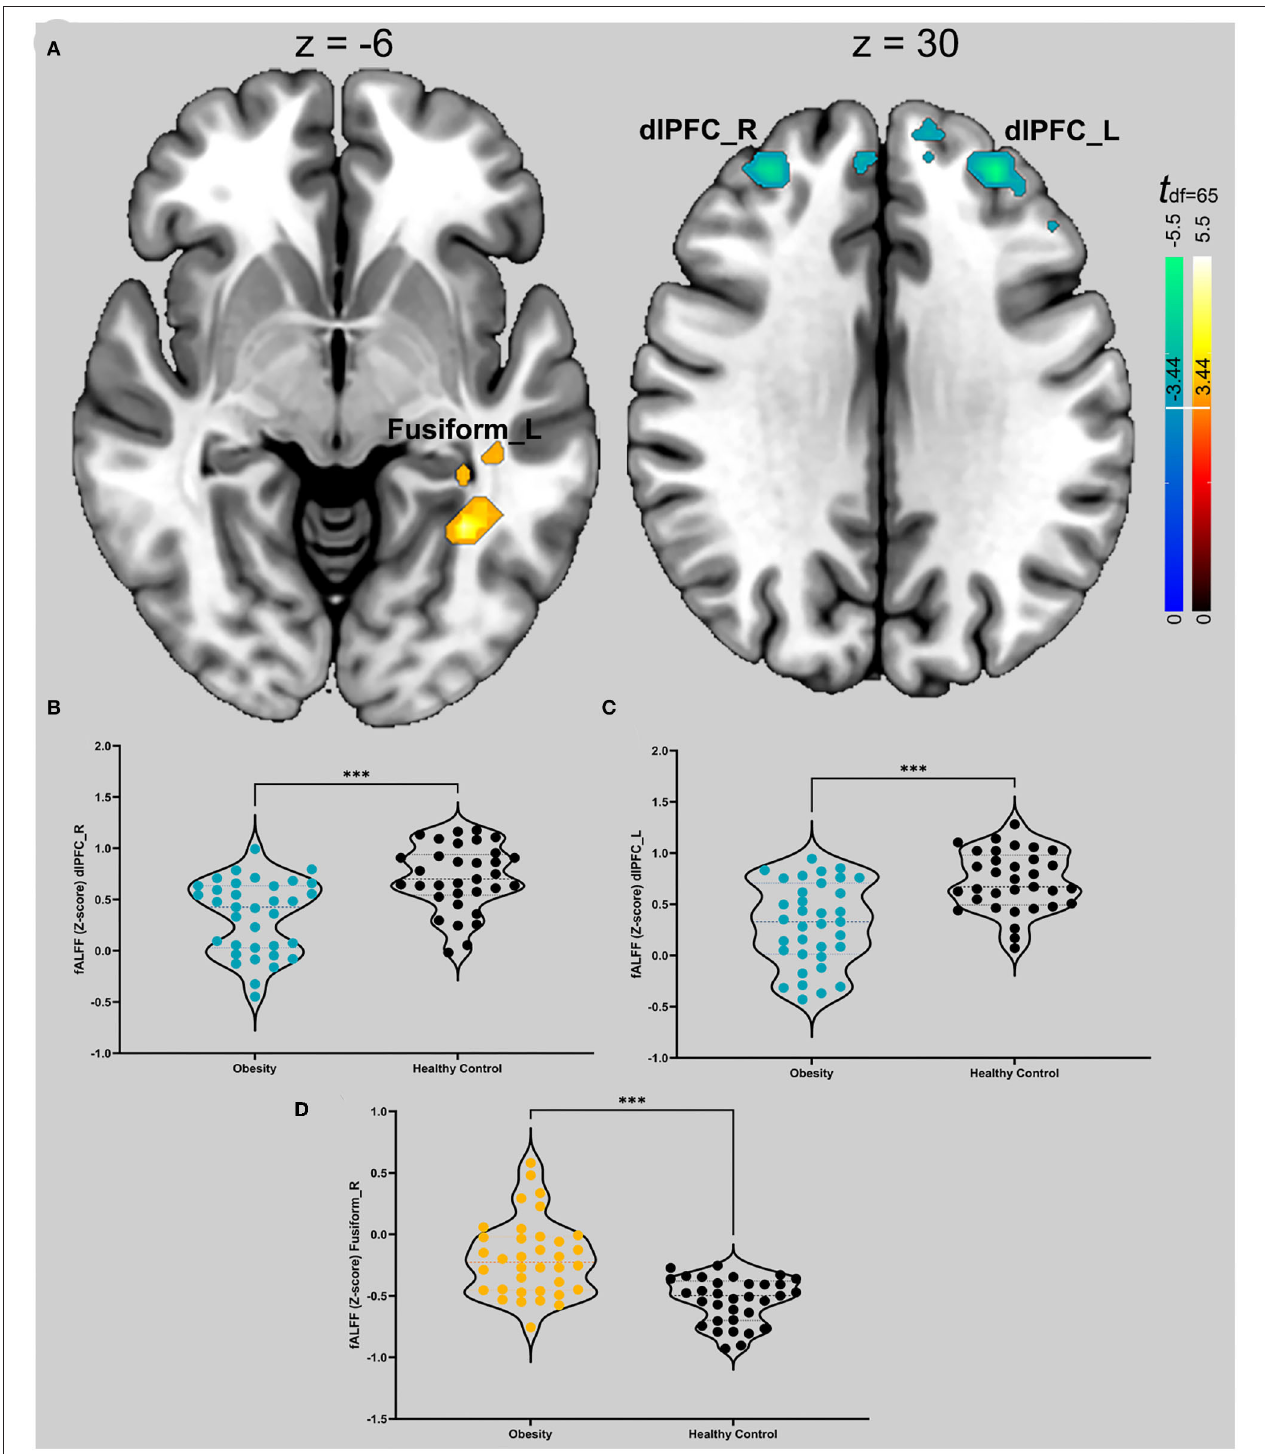
FIGURE 1 | (A) t map of differences in spontaneous activity of the groups. Hot colors (red to bright yellow) indicate that obese patients have higher spontaneous brain activity in those regions; cool colors (blue) indicate that obese patients have lower spontaneous activity. The thresholds for the two comparisons are ± 3.44. The slice on the graph is the cross section of the vertical axis with the maximum threshold. (B) Violin diagrams of the intensity values corresponding to the dlPFC of the two groups on the right. The colored dots in the figure are obese patients, and the black dots are healthy controls. The dotted lines represent the first, second, and third quantiles. We used an independent samples t test. *** Indicates p < 0.001 in (A–D) . (C) Violin graphs of the intensity values corresponding to the left dlPFC in the two groups. (D) Violin graphs of the intensity values corresponding to the left fusiform gyrus in the two groups.